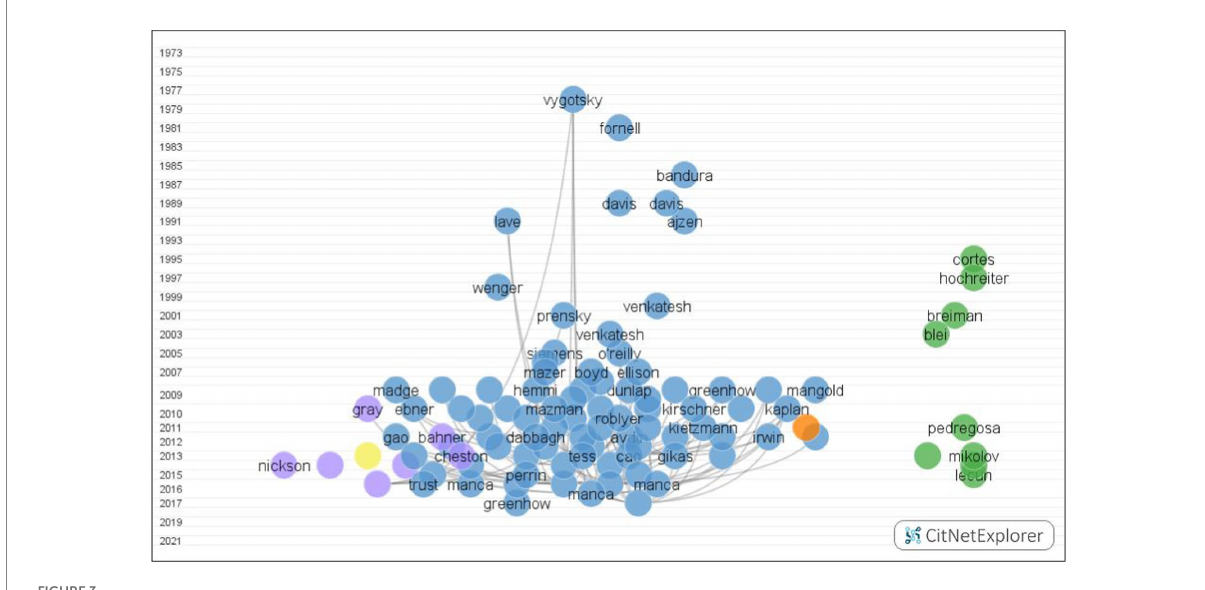
FIGURE 3 Citation networks of 100 publications.